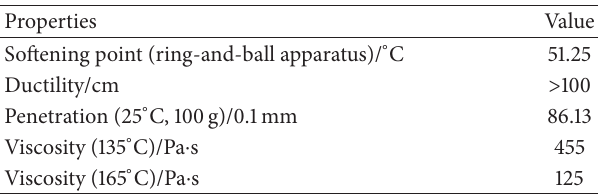
Table 1: The properties of base asphalt. Table 2: Modifier proportions in modified